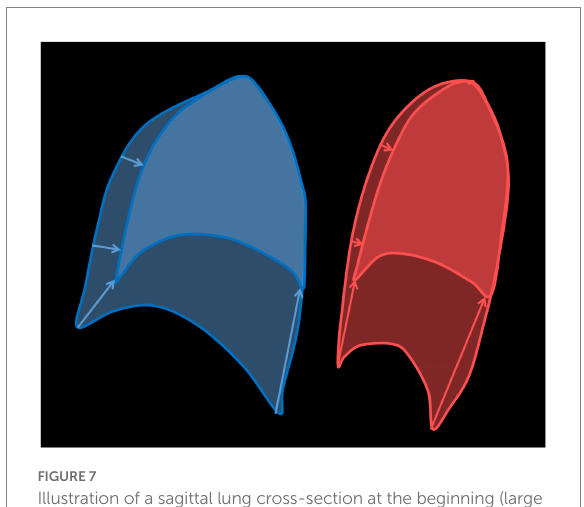
FIGURE 7 Illustration of a sagittal lung cross-section at the beginning (large area) and at the end (small area) of a phonation with drawing of the sex-specific movement ranges (arrows) for a male (blue) and a female (red)